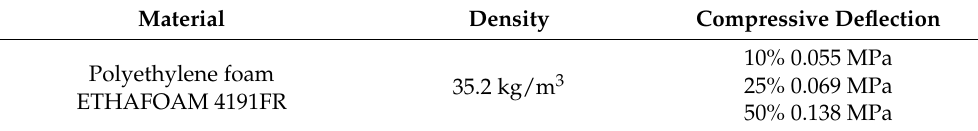
Table 5. Cushion foam’s mechanical properties.